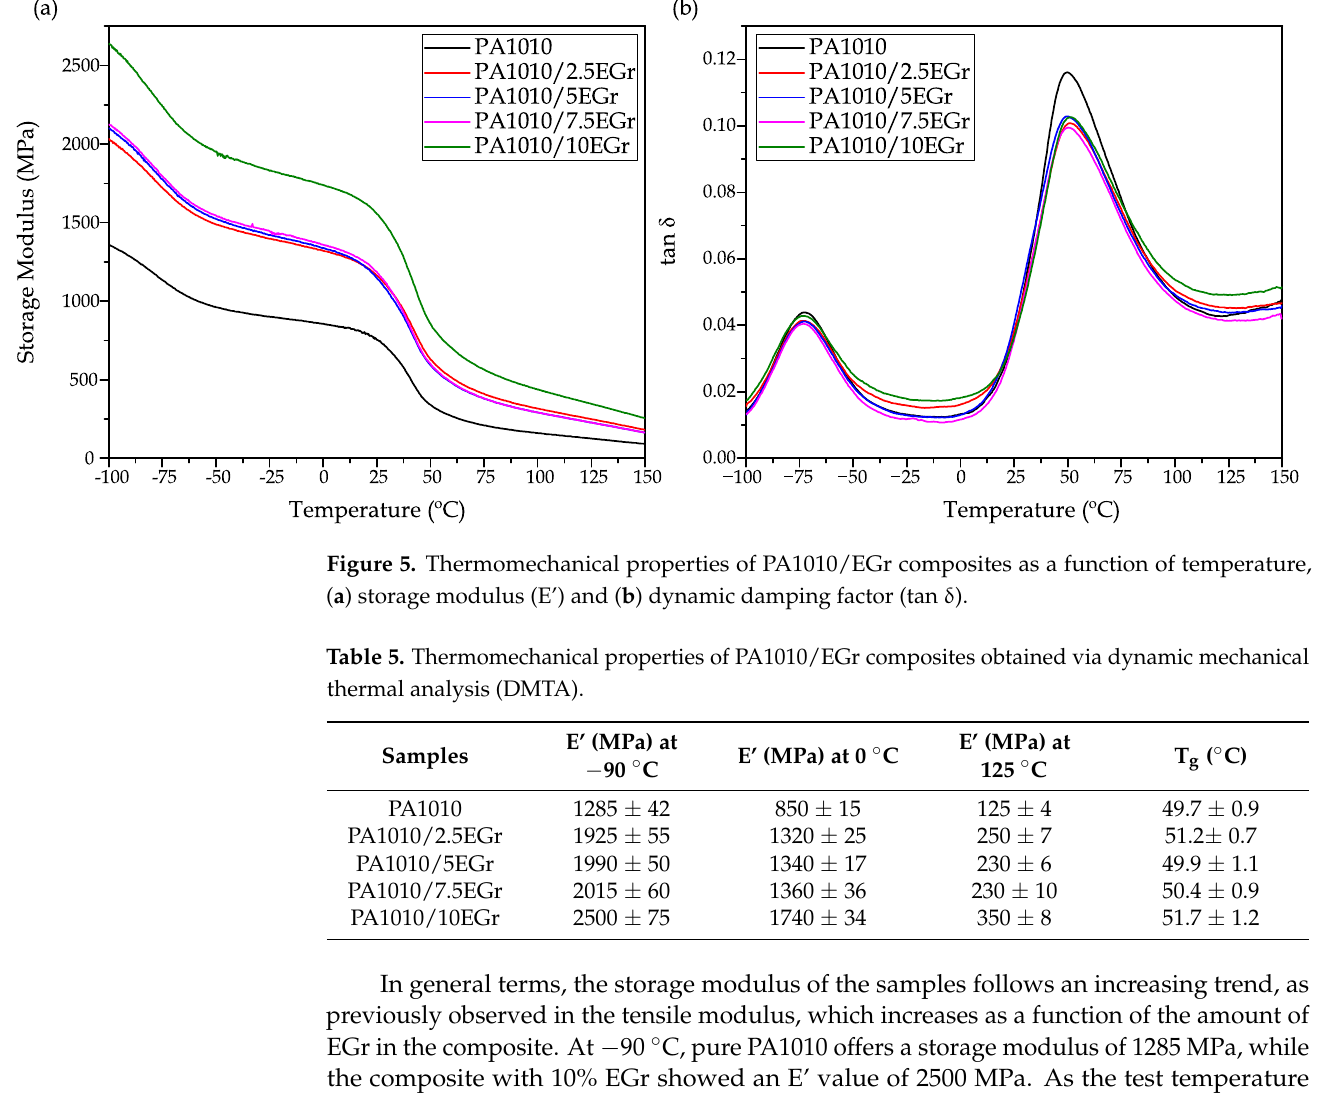
Figure 4. Thermal degradation of PA1010/EGr composites, ( a ) thermogravimetric (TGA) curves and ( b ) first derivative (DTG) curves.